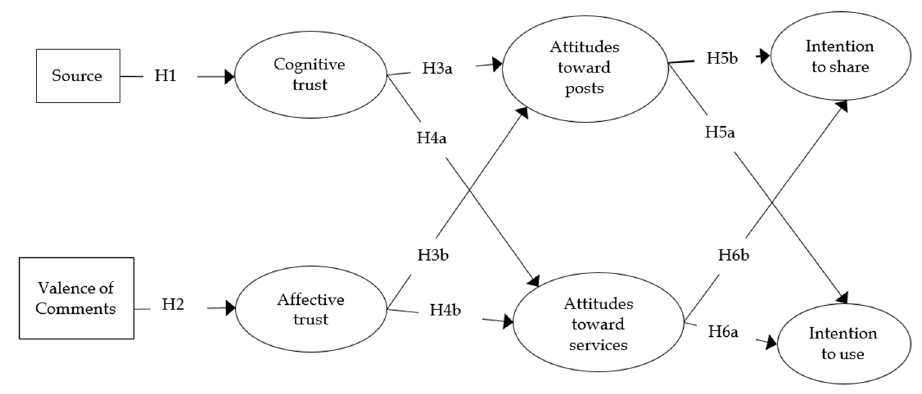
Figure 1. Conceptual Model of Source and Valence of Comments on Behavioral Intentions.